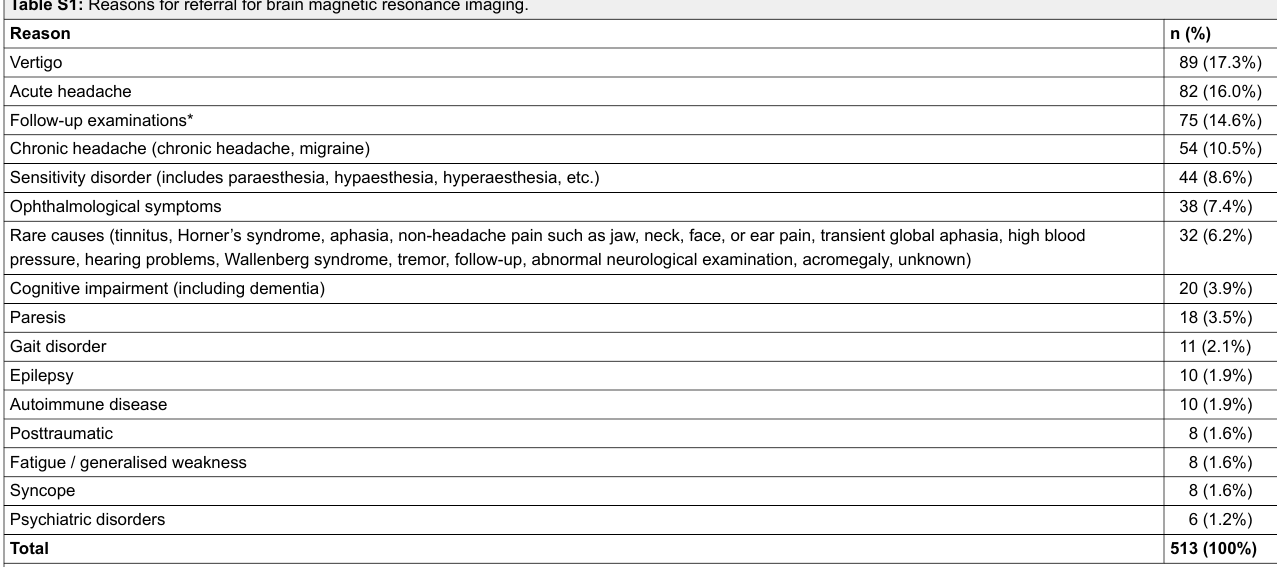
Table S1: Reasons for referral for brain magnetic resonance